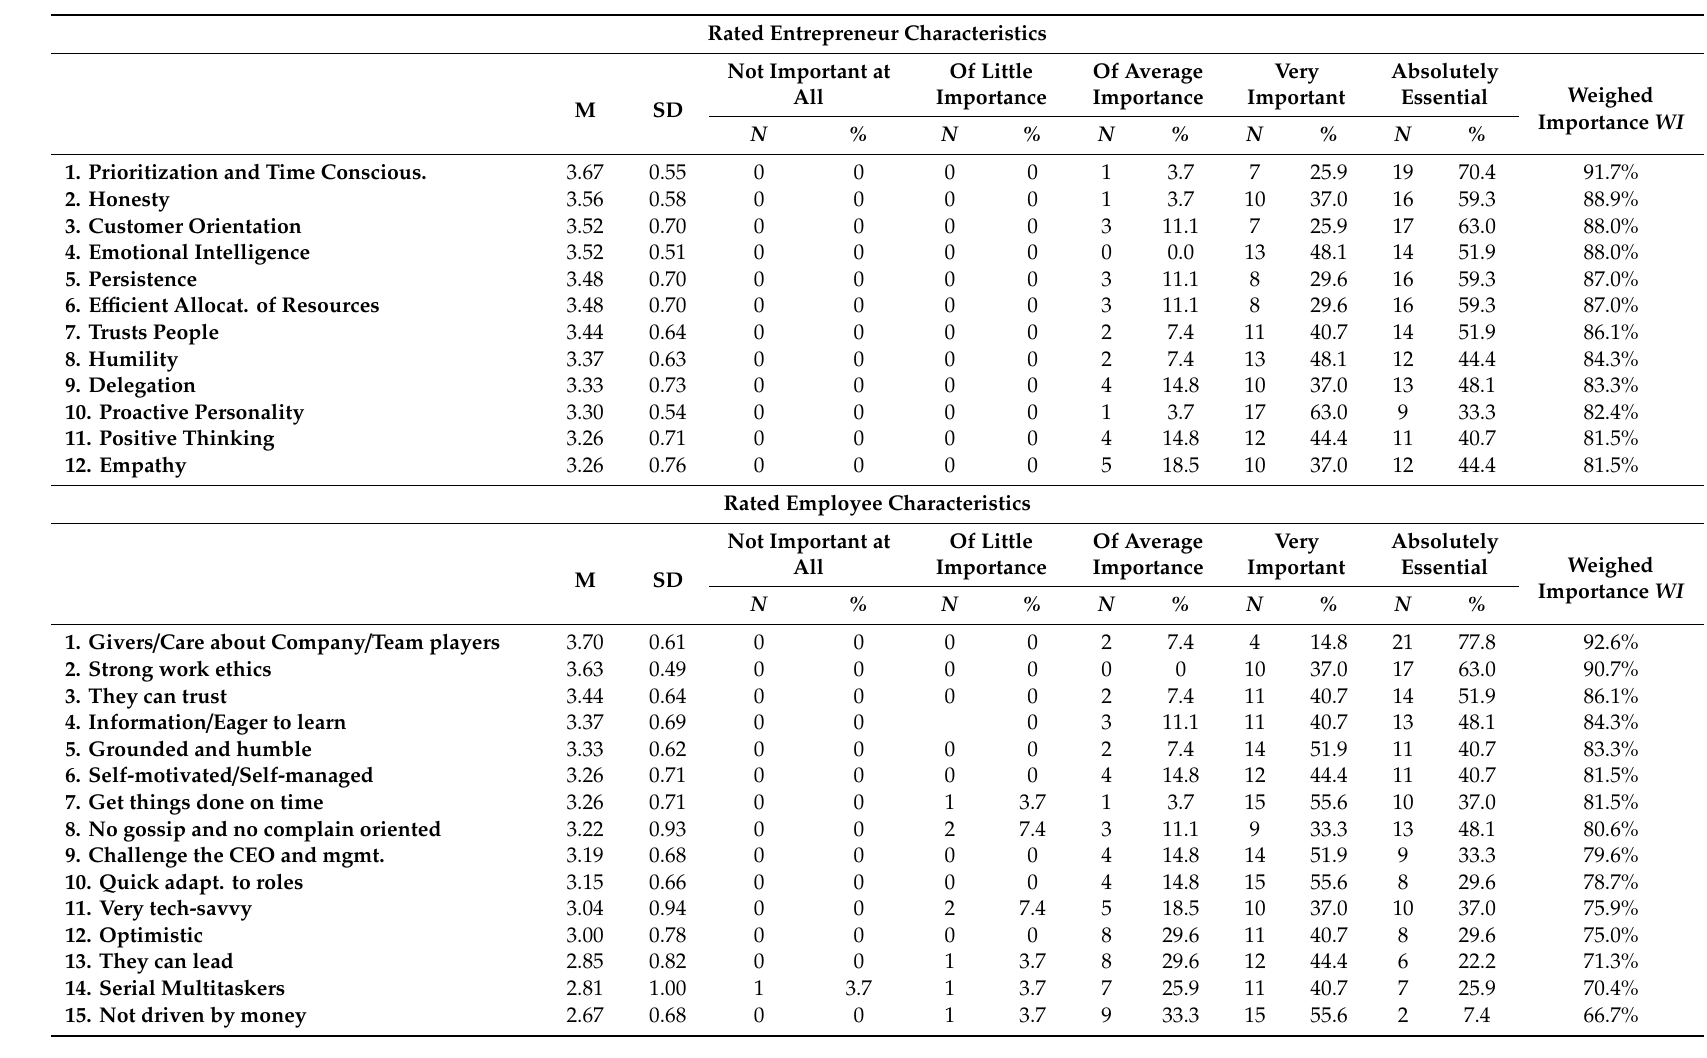
Table 8. Rated Importance of Entrepreneur and Employee Characteristics in Innovative Technology